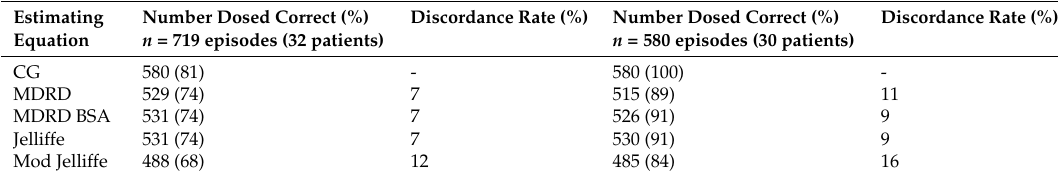
Table 4. Dose appropriateness for all drugs.